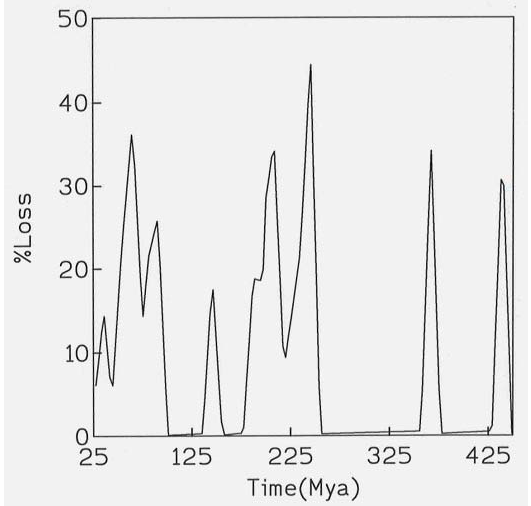
FIGURE 2. The percentage loss of species and genera for a number of major mass extinctions over the last 440 my vs. event time (mya) are shown as a peak-and-trough diagram. The data used are from Table 3.